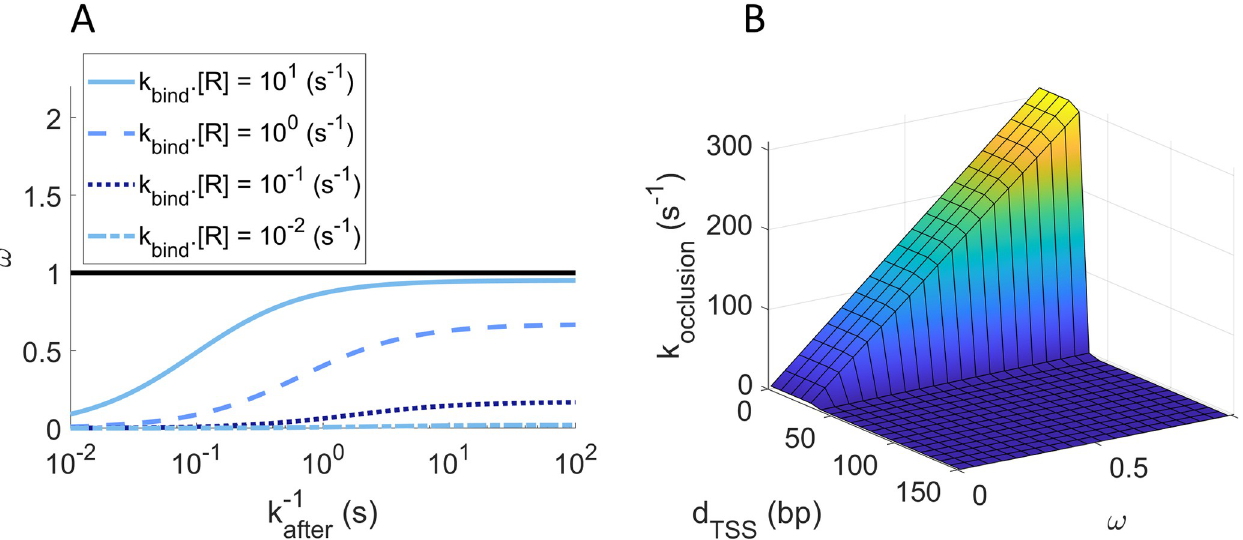
Fig 8. Promoter occupancy ω estimated for the step model. (A) ω as a function of the rate constant for a free RNAP to bind to the unoccupied promoter ( k � [ R ]) and of the time for that RNAP to start elongation after commitment to OC, k (cid:0) 1 bind that the promoter can be occupied (i.e., the maximum promoter occupancy). (B) k occlusion plotted as a function of ω and d TSS . Since k occlusion increases with ω if and only if d � 35, it renders the simultaneous occupation of both TSS’s impossible. TSS